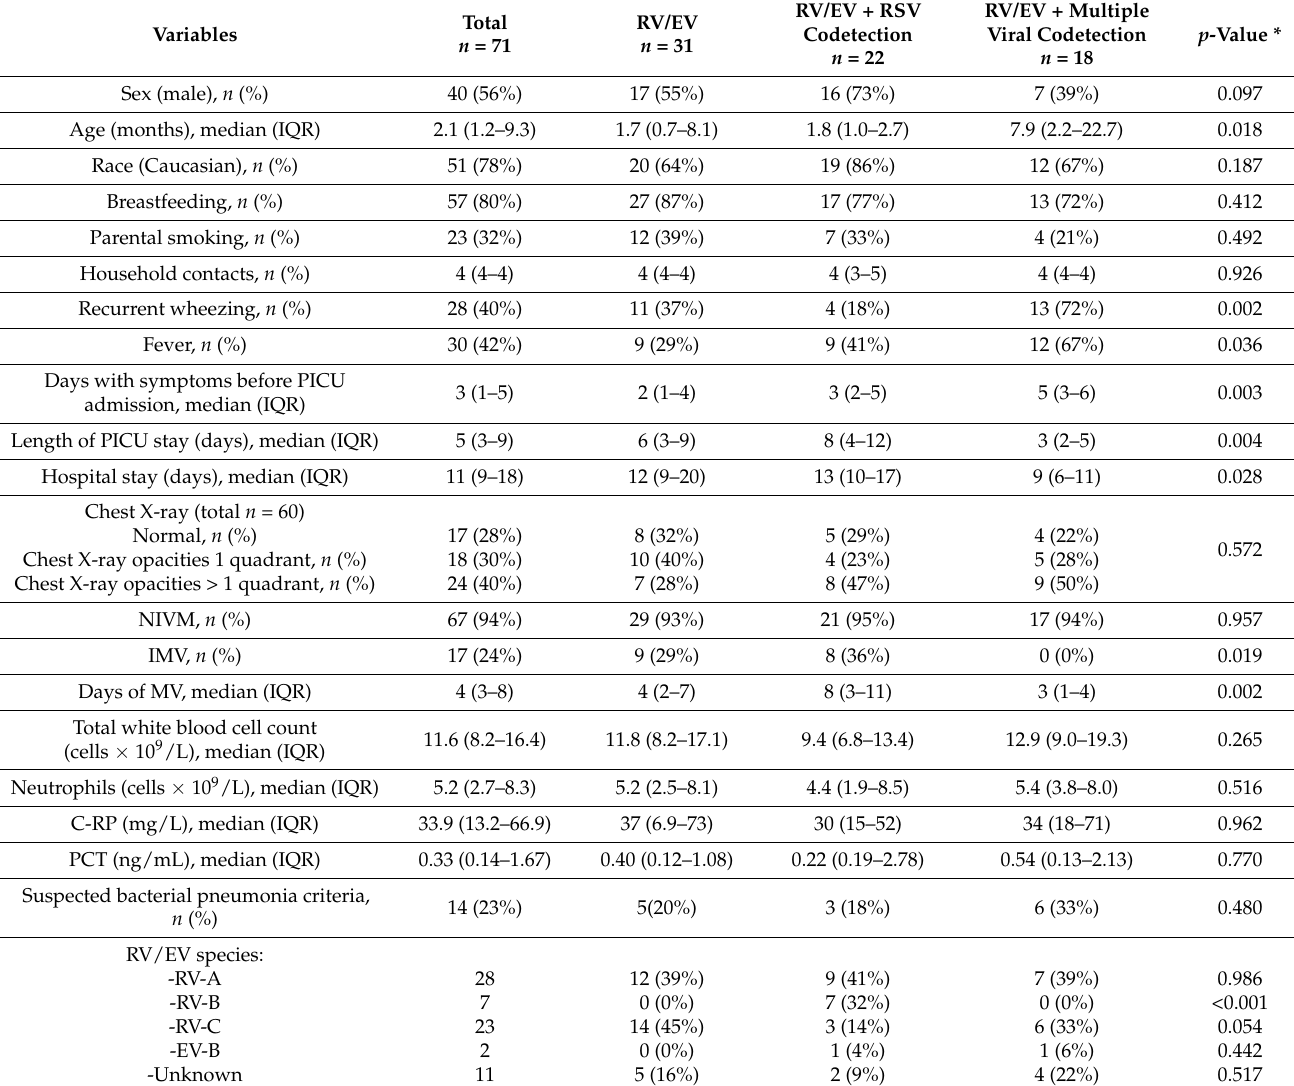
Table 1. Demographic, clinical, and microbiological characteristics of children with RV/EV detection, RV/EV + RSV codetection, and RV/EV + multiple viral